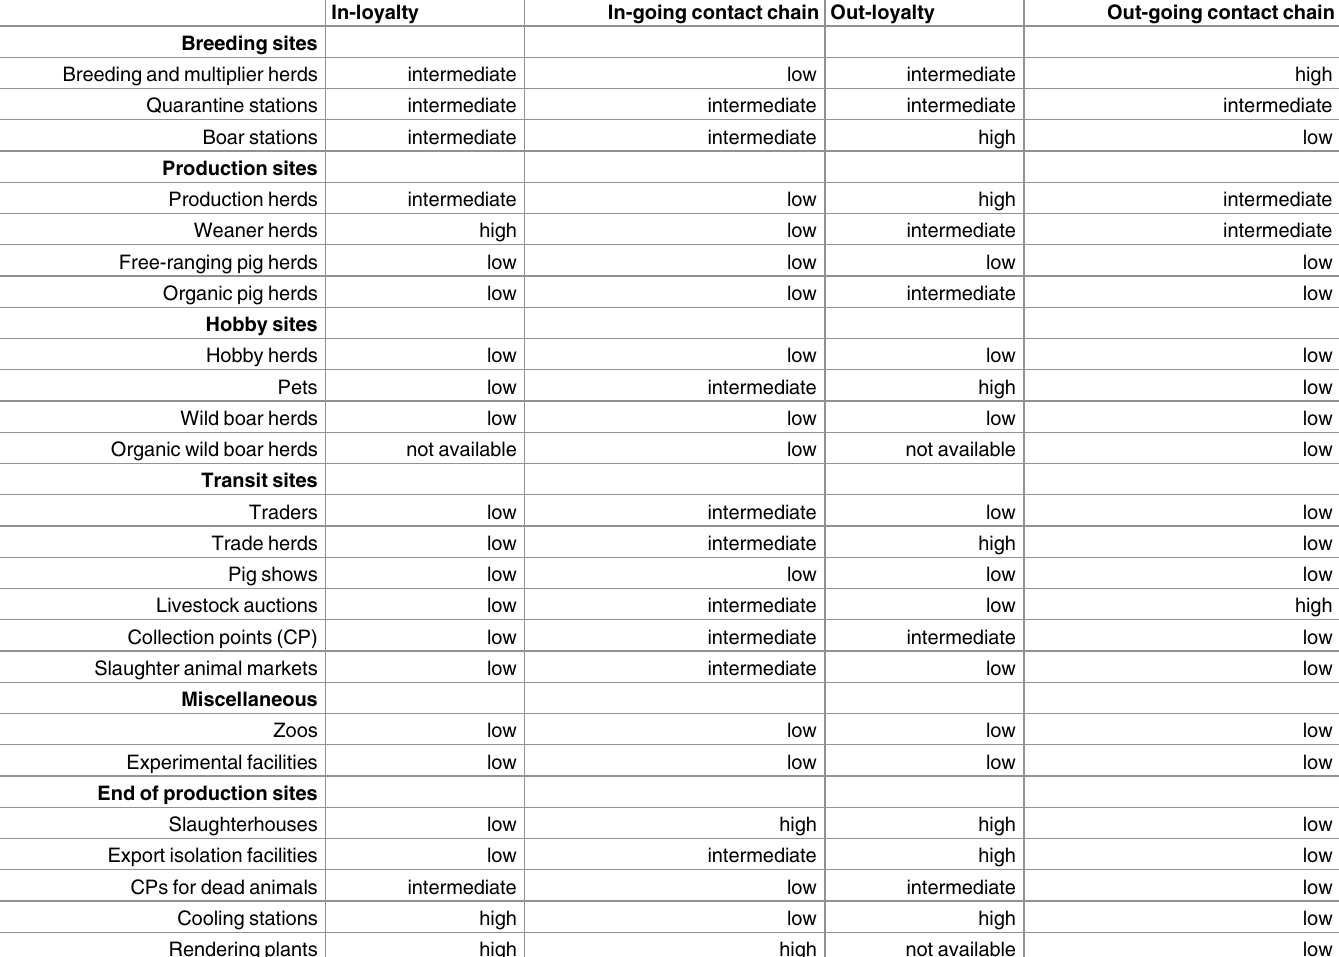
Table 2. Levels of loyalty and contact chains for different pig holding types in Denmark, based on data from the CHR, 1 st January 2006 – 31 st